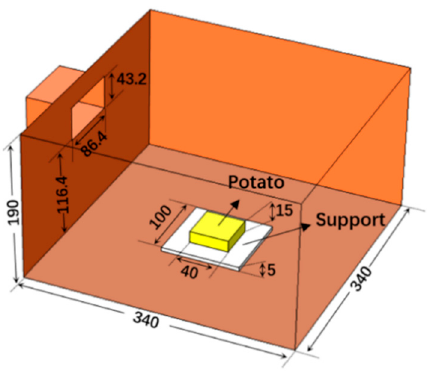
Figure 1. Geometry of the 3-D simulation model (unit: mm).